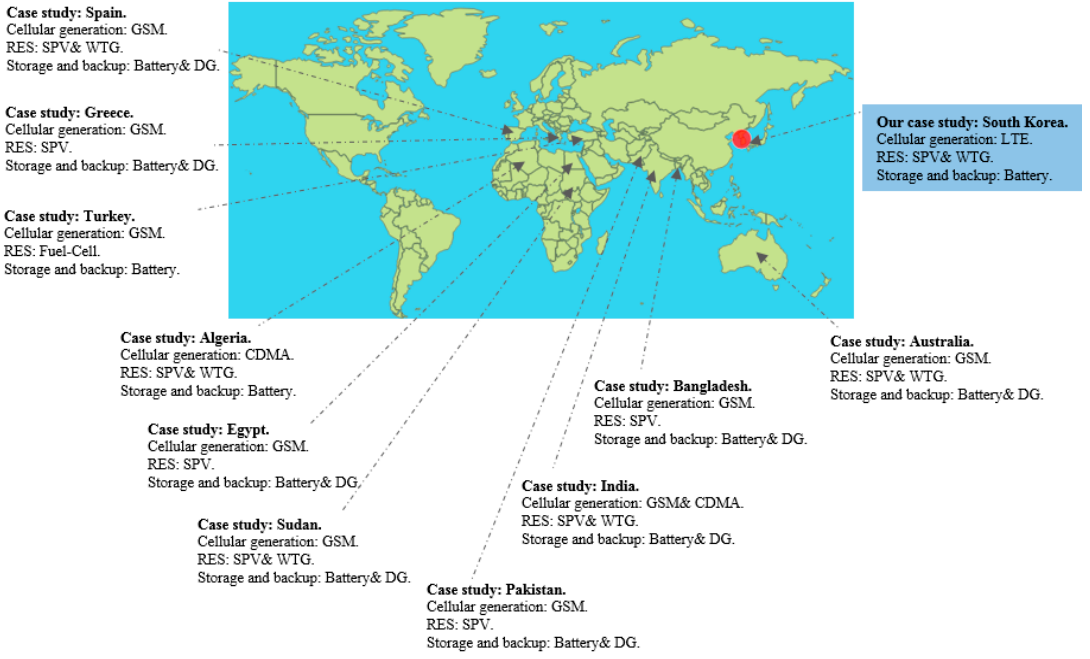
Figure 1. Summary of related works of green wireless network optimisation strategies within smart grid environments [11–19].